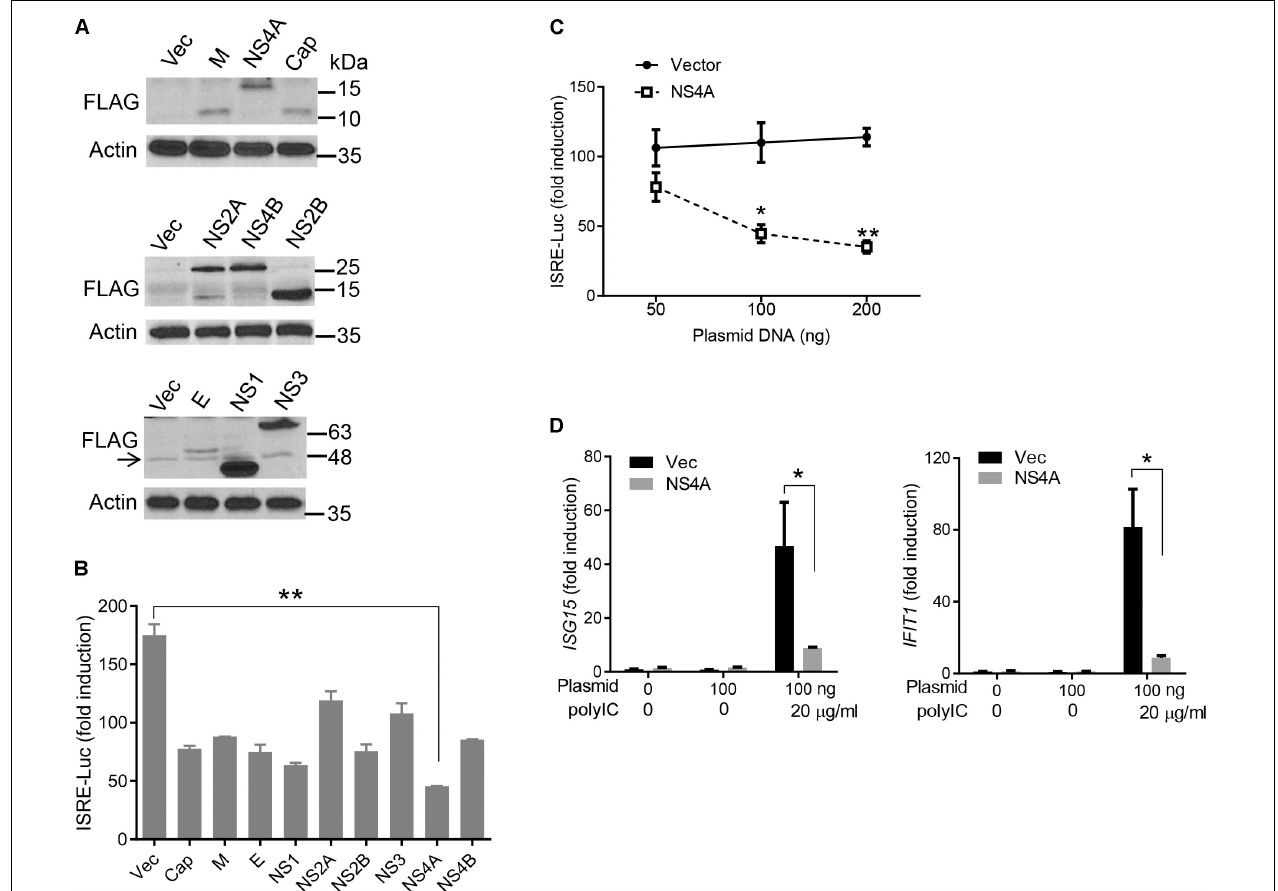
FIGURE 2 | NS4A inhibits polyI:C- induced type I IFN responses. (A) Immunoblots of the FLAG-tagged ZIKV protein expression in HEK293T cells. The proteins were detected by immunoblotting with an anti-FLAG antibody. Actin is a housekeeping protein control. The arrow indicates a non-specific band. The molecular weights in kDa are marked to the right of the blots. (B) Quantification of ISRE-Luc activity in HEK293T cells transfected with either 100 ng of empty vector or the indicated ZIKV gene expressing plasmid for 24 h and then stimulated with 10 µ g/ml of heavy molecular weight polyI:C-H for 16 h. Data are expressed as fold induction over unstimulated cells. (C) Quantification of ISRE-Luc activity by a dual luciferase reporter assay similar to B except that an increasing dose of vector and FLAG-NS4A plasmids was applied. (D) Quantification of ISG15 and IFIT1 mRNA by q-PCR in HEK293T cells transfected with either 100 ng of empty vector or NS4A, and then stimulated with polyI:C as in B . The bars/data points in B–D represent the mean + SEM of the results, n = 3. ∗ p < 0.0.5; ∗∗ p < 0.01 (Student’s t -test). The data shown are representative of three independent